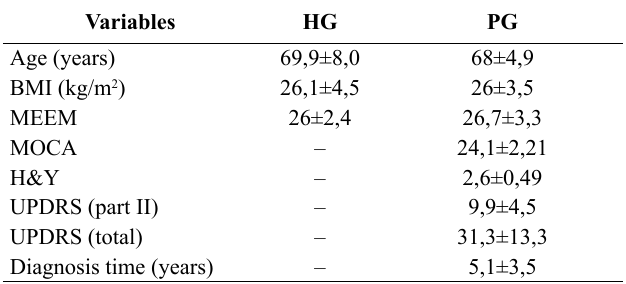
Table 1. Subject characteristics.